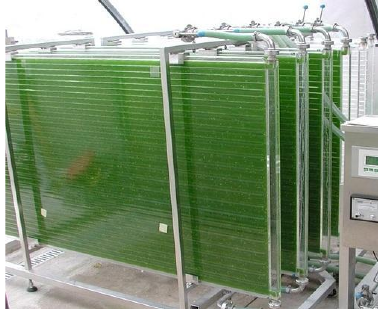
Fig. 3. Bioreactor (Bioneer